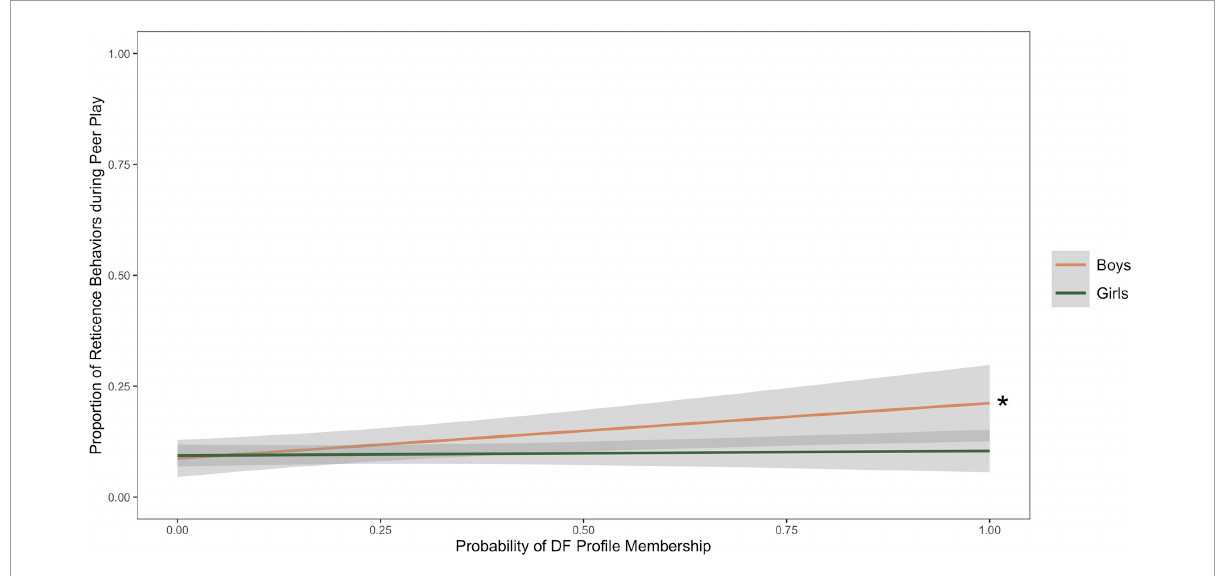
FIGURE4 Line graph depicting associations between the probability of dysregulated fear (DF) profile membership and proportion of reticence behaviors during a peer play task, with child sex as a moderator. The symbol ∗ indicates a significant slope ( p <